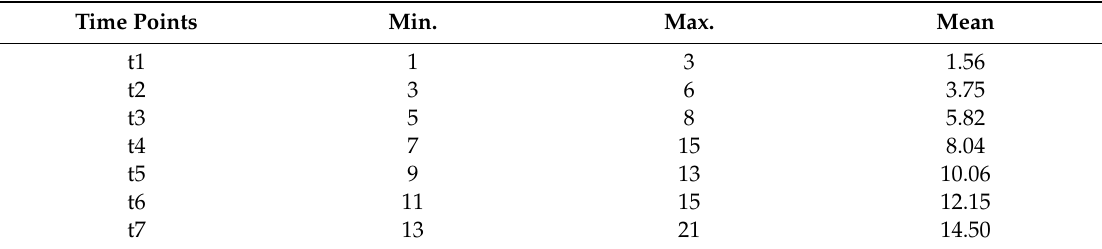
Table 3. Time points at the three centers regarding stool sampling of 54 preterm infants < 1500 g during the first two weeks of life. Time Points Min.